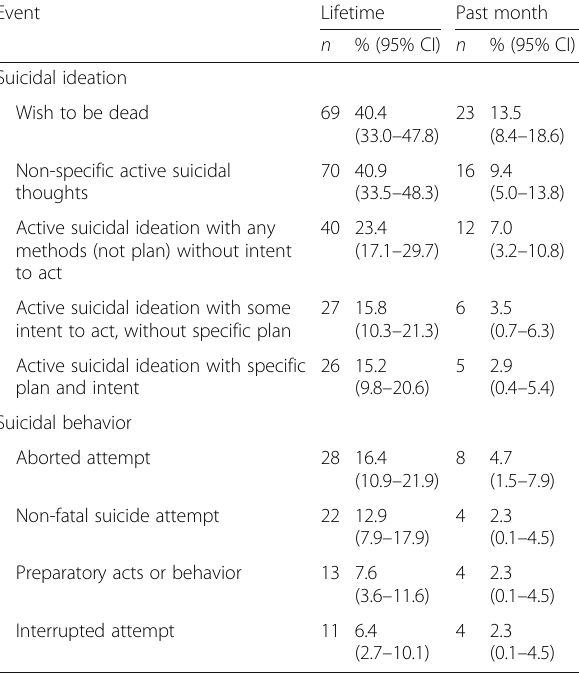
Table 2 Proportion of surveyed ALS learners with lifetime